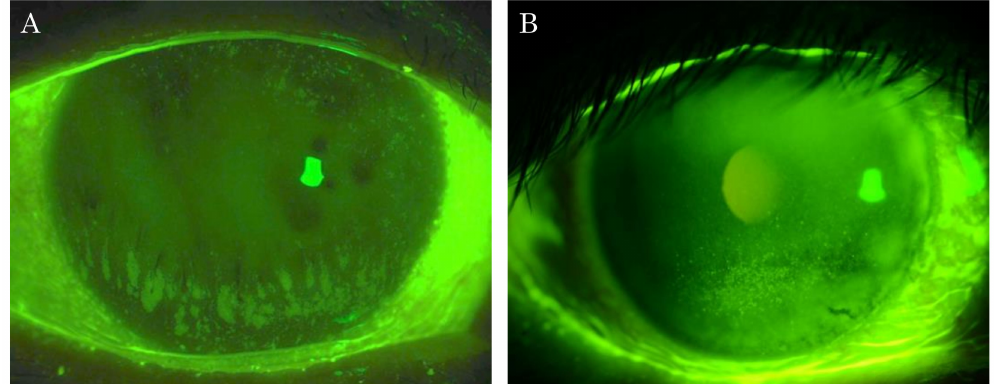
Figure 2. Representative photographs of the fluorescein patchy pattern corneal staining (PPCS) and superficial punctate keratopathy (SPK) without PPCS. PPCS can be seen at the lower part of the cornea ( A ) and SPK without PPCS can also be seen at the lower part of the cornea ( B